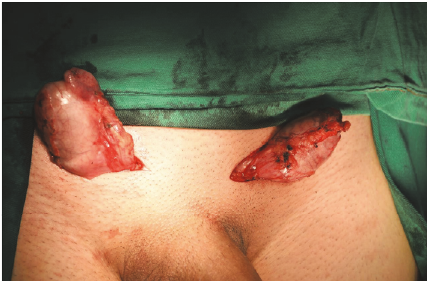
Figure 3: Patient with bilateral testicular